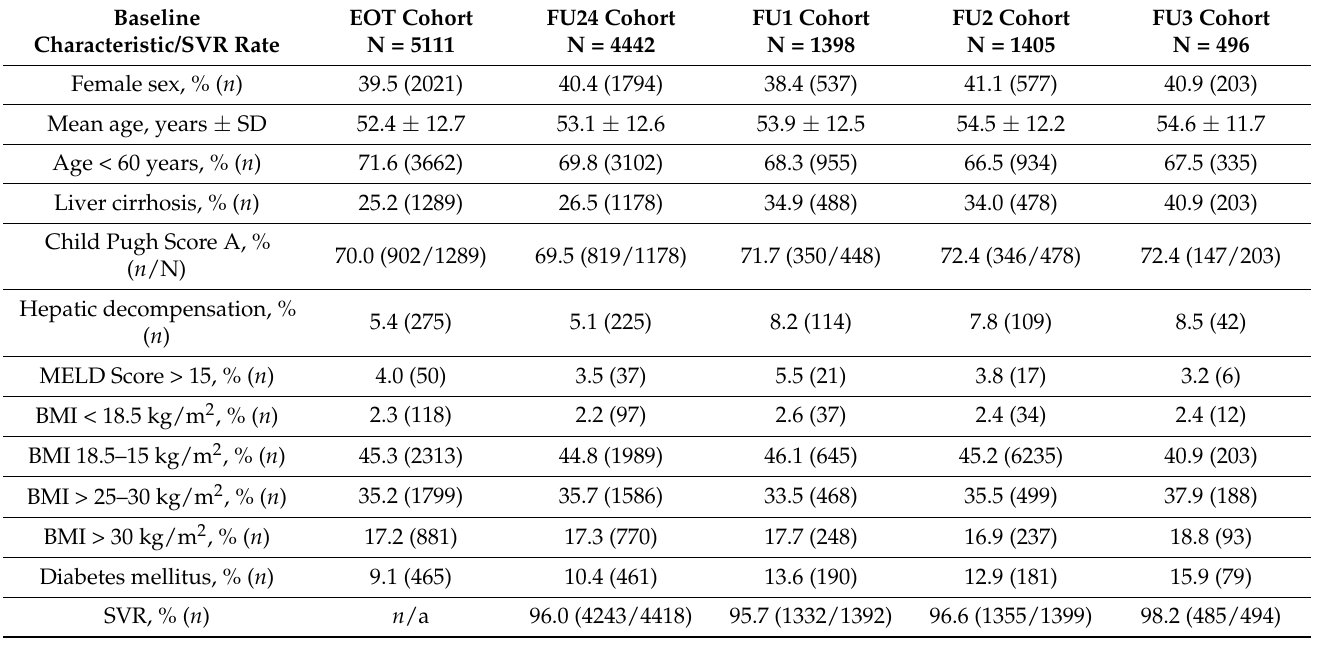
Table 1. Baseline characteristics and SVR rates of the EOT, FU24, FU1, FU2, FU3 cohorts of DAA treated patients in the German Hepatitis